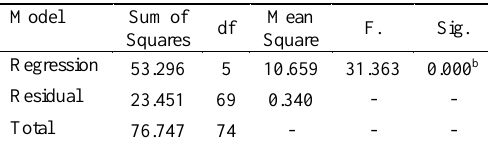
Table 1: Analysis of Variance